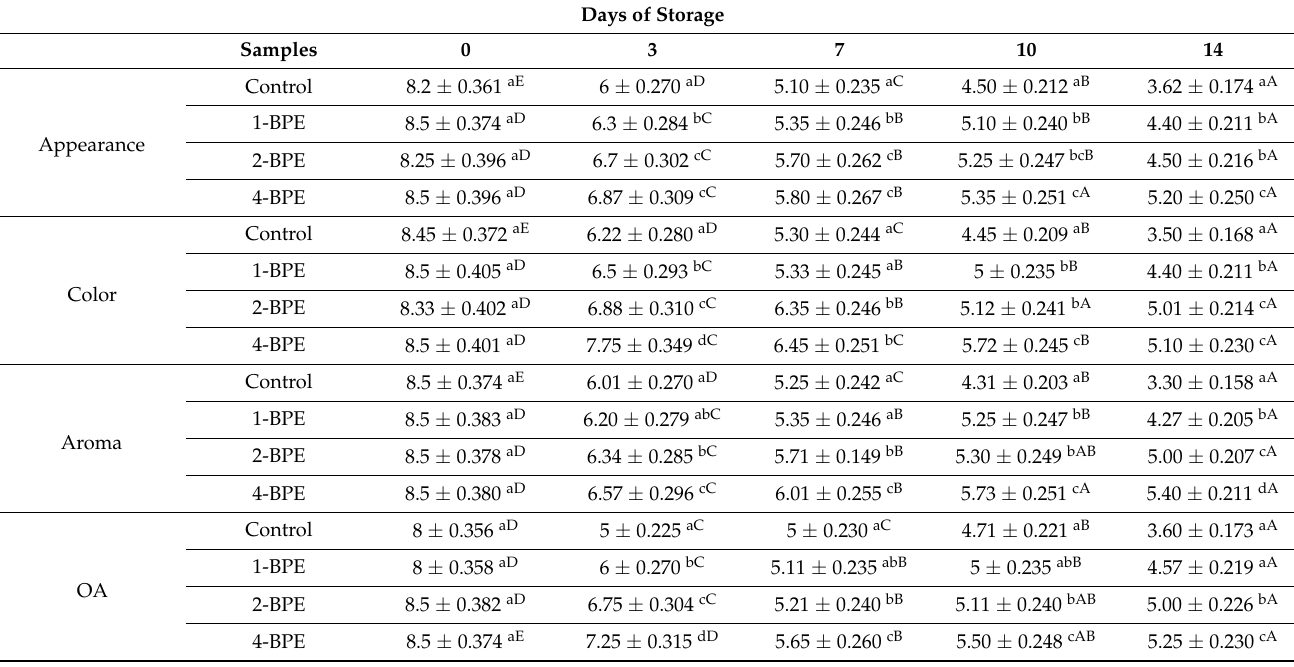
Table 9. Effect of the films on appearance, color, aroma, and OA of raw minced meat samples stored at 4 ◦ C for 14